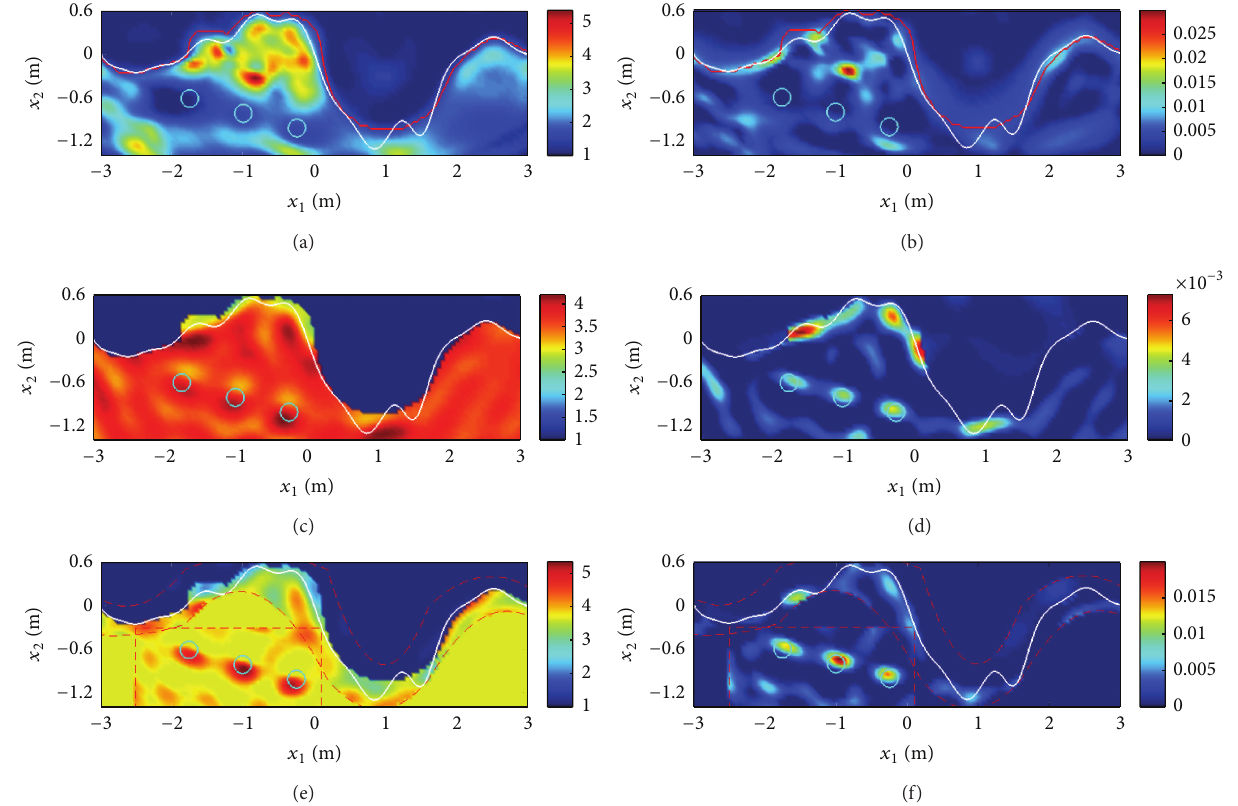
Figure 7: (a) Reconstructed permittivity and (b) conductivity profiles and the determination of the rough surface after the first stage. Final results of permittivity and conductivity profiles ((c)-(d)) for the entire domain and ((e)-(f)) for the narrowed